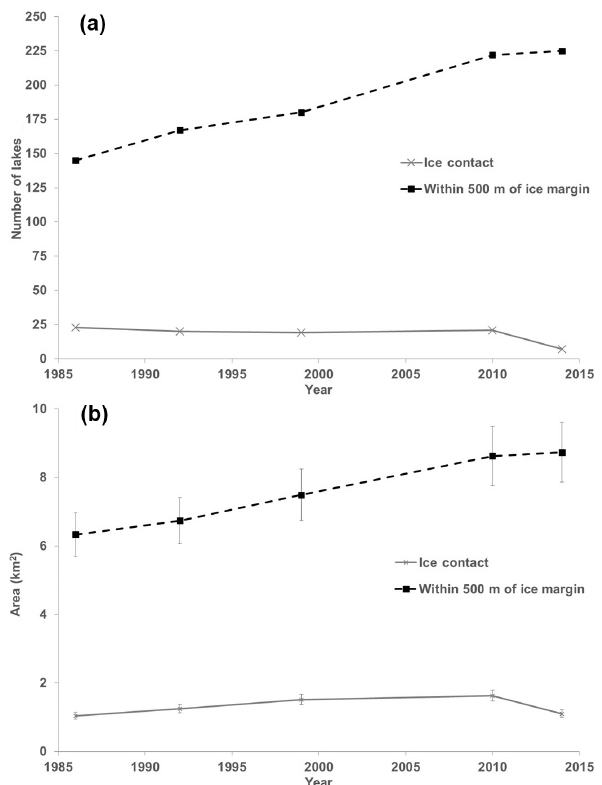
Figure 8. Total change in proglacial lake number (a) and areal cover (b) according to distance from ice margin (i.e. ice contact and within 500m of the 1986 ice margin). Error bars are determined using Eq. (1) and represent an uncertainty of ±